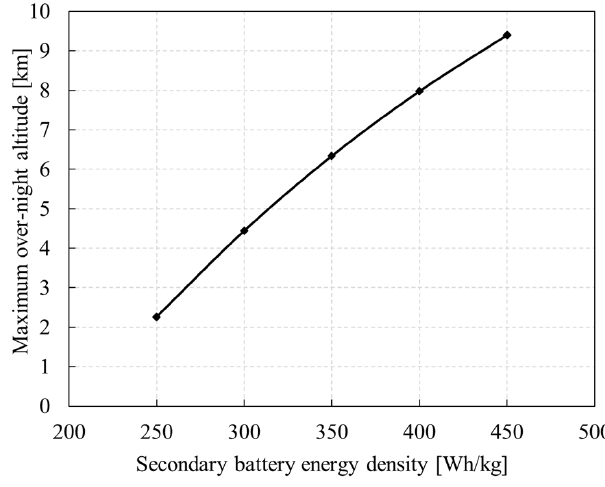
Figure 37. Variation of maximum overnight altitude with secondary battery energy density.